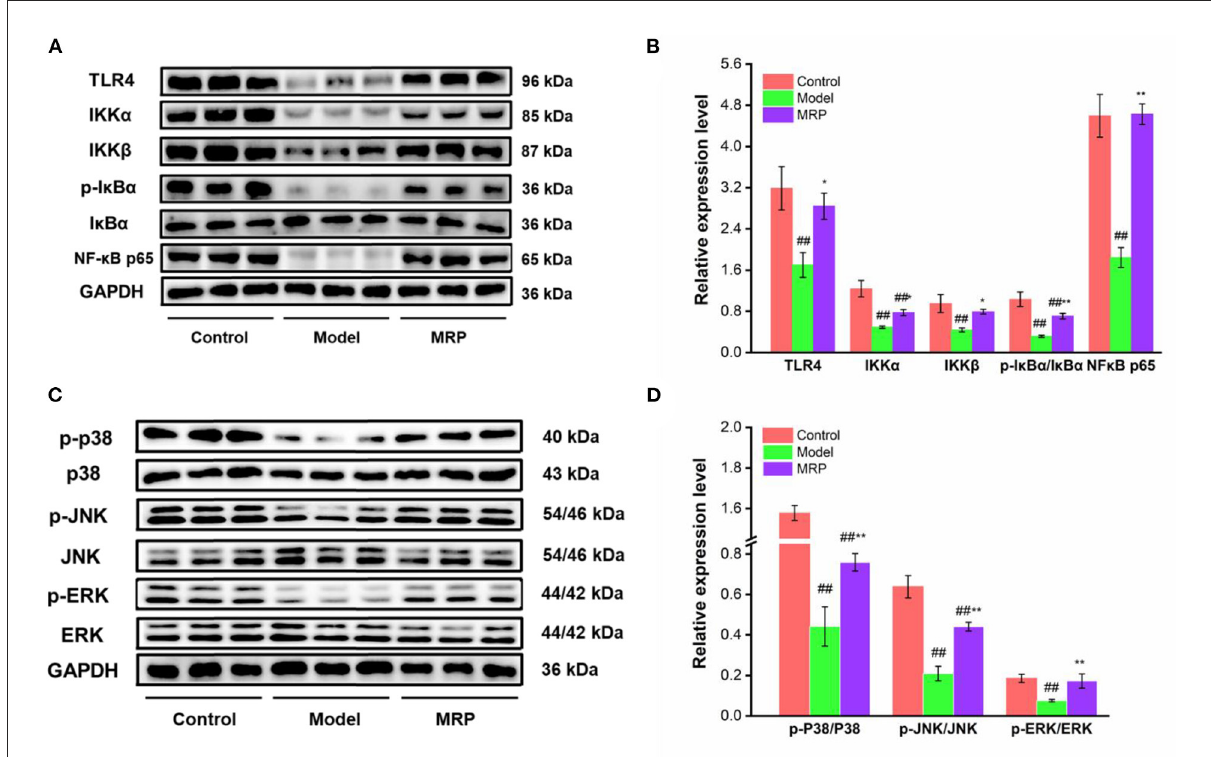
FIGURE7 Effect of MRP on the protein levels in the NF- κ B and MAPK pathways ( n = 3). (A) Western blot of NF- κ B pathway. (B) The protein levels of related proteins in the NF- κ B pathway. (C) Western blot of MAPK pathway. (D) Protein levels of related proteins in the MAPK pathway. ## P < 0.01 vs. Control; * P < 0.05 and ** P < 0.01 vs.